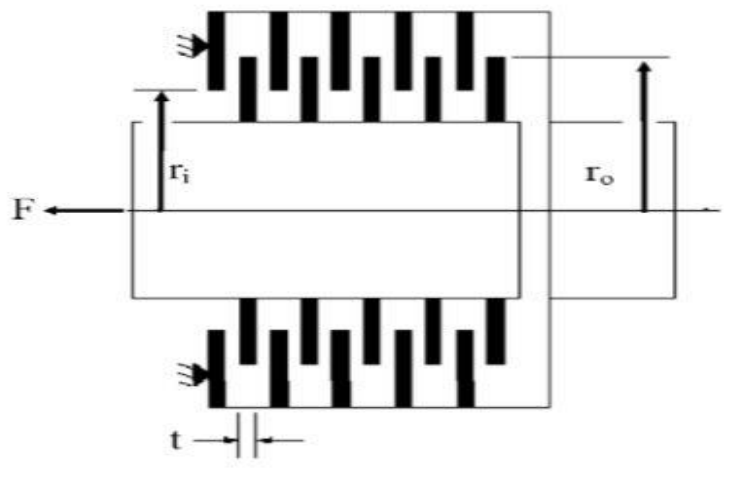
Figure 2: Multiple Disc Clutch Schematic